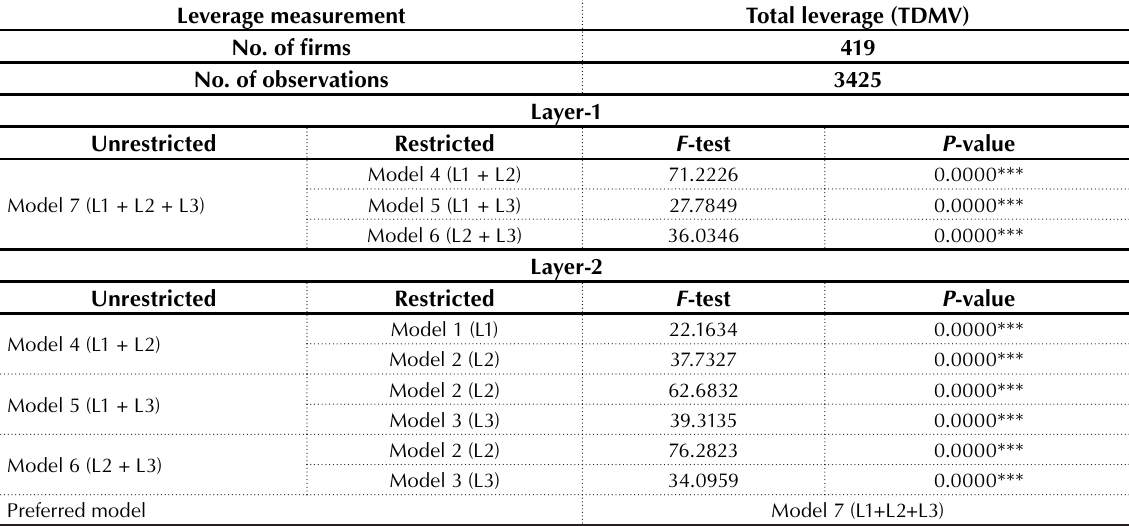
Table 4. Model selection of relationship between debt ratio and three level determinants – full sample data